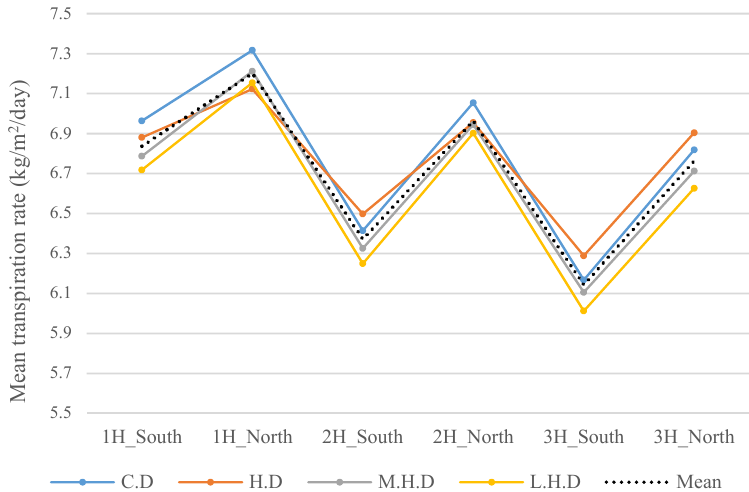
Figure 10. Mean change of transpiration rate with LAD distribution, tree location, and building height scenarios.